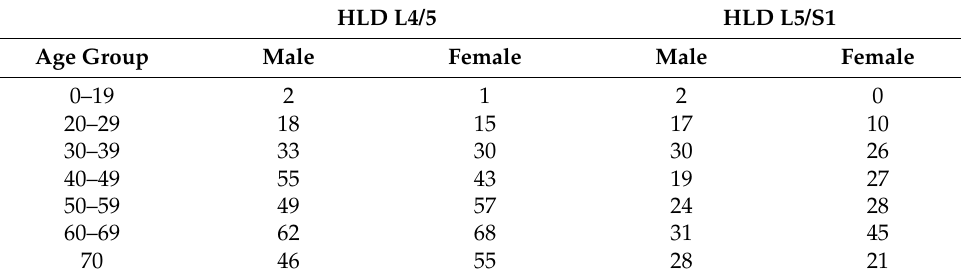
Table 1. Age and sex distribution of DITI data.